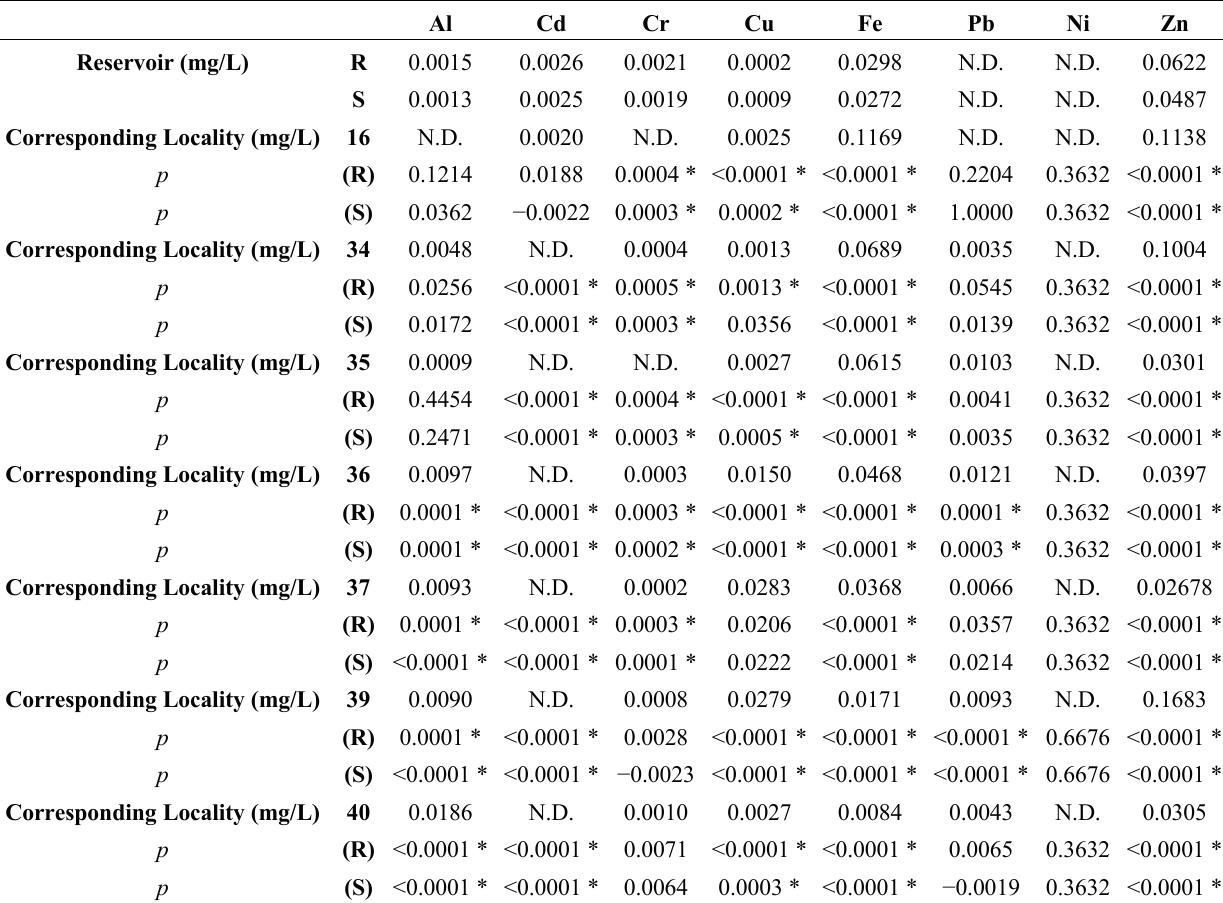
Table A13. Statistical variation between Reservoirs R and S and their feeding Localities